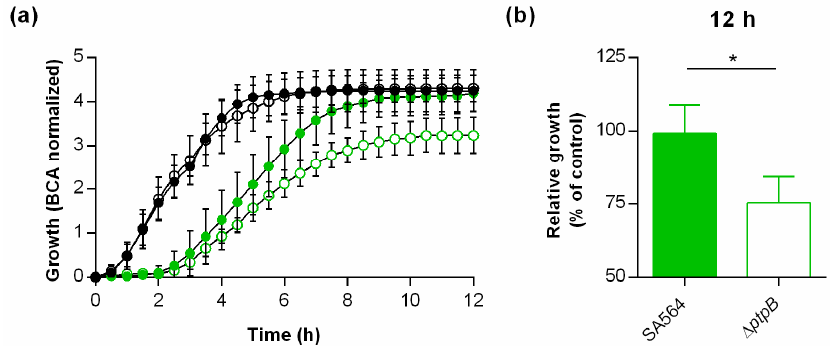
Figure 6. Effect of a ptpB deletion on the NO˙ resistance of S. aureus SA564. Cells of S. aureus strain SA564 (filled symbols) and its isogenic ∆ ptpB mutant (opened symbols) were cultured in presence and absence of 12.5 µM DEA NONOate in TSB under static conditions at 37 °C and 5% CO 2 for 12 h. Growth was measured by optical density using the oCelloScope BCA algorithm. ( a ) Growth kinetics of DEA NONOate treated (green symbols) and untreated (black symbols) cell suspensions. The graph represents the average growth values ± SD of four biological experiments. ( b ) Relative growth rates of DEA NONOate treated cells in relation to the growth rates recorded for the untreated controls at 12 h of growth. * p < 0.05 (Mann-Whitney U